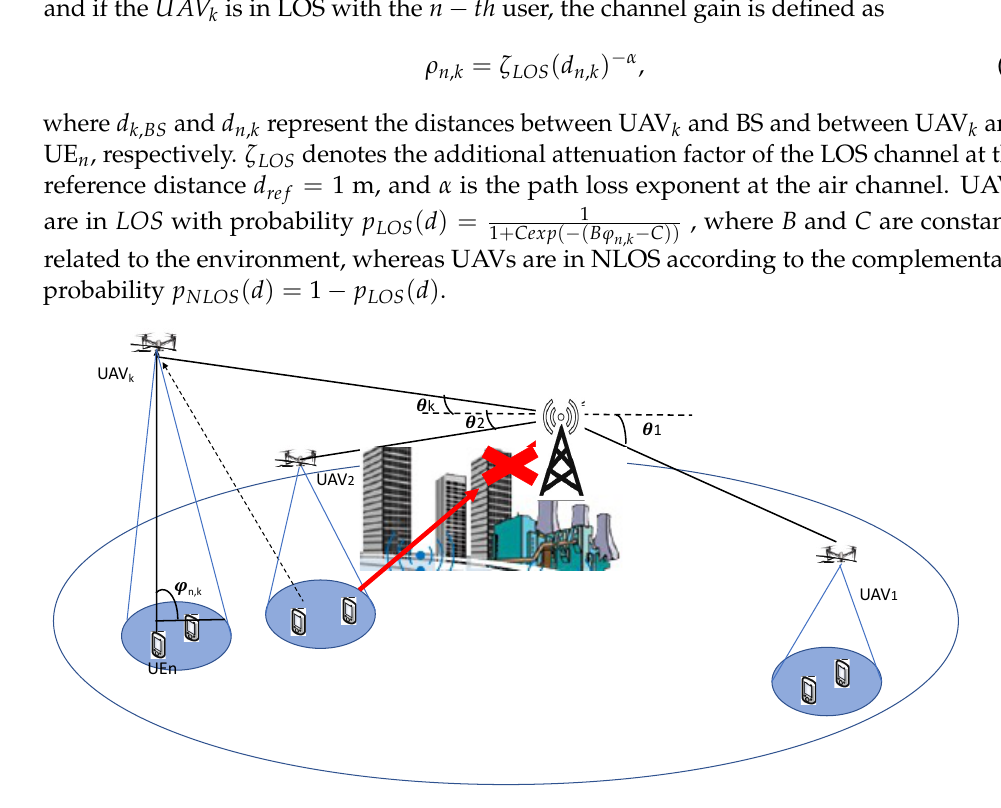
Figure 1. Multiple-UAV-relay-network-aided mmWave NOMA cellular